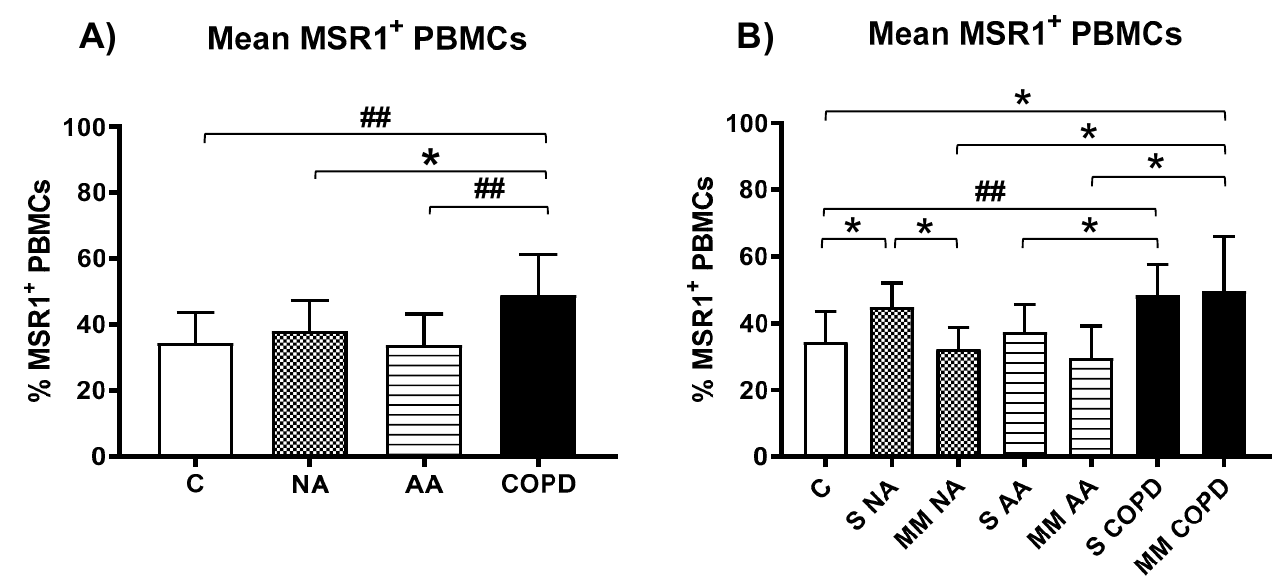
Figure 3. Expression of MSR1 on PBMCs. C: Control ( n = 11), NA: Nonallergic Asthma ( n = 11), AA: Allergic Asthma ( n = 13), COPD ( n = 11), S: severe diagnosis; MM: moderate–mild diagnosis. Mean percentages of total MSR1 + expressing cells in the whole PBMCs fraction ( A ) by clinical group and ( B ) according to disease severity. Statistically significant differences among groups are shown as: * ( p < 0.05) and ## ( p < 0.001).